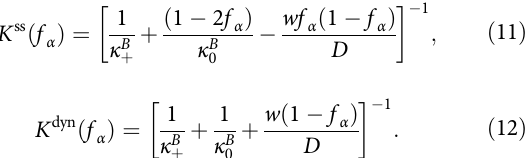
NATURE COMMUNICATIONS| (2021) 12:1721